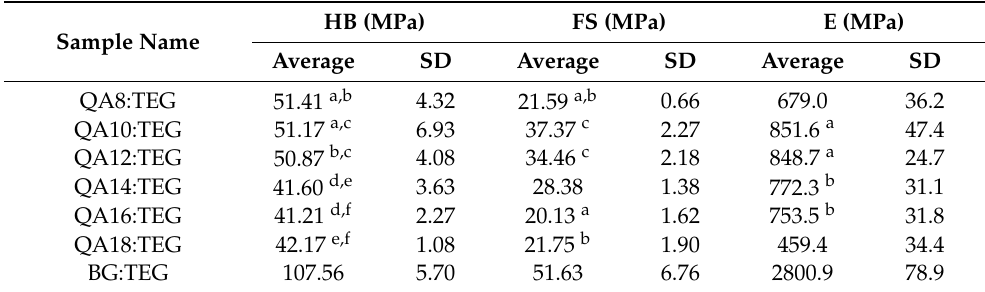
Table 2. Mechanical properties of the studied copolymers: hardness ( HB ), flexural strength ( FS ), and flexural modulus ( E ). Lower case letters indicate statistically insignificant differences ( p > 0.05) with a column (non-parametric Wilcoxon